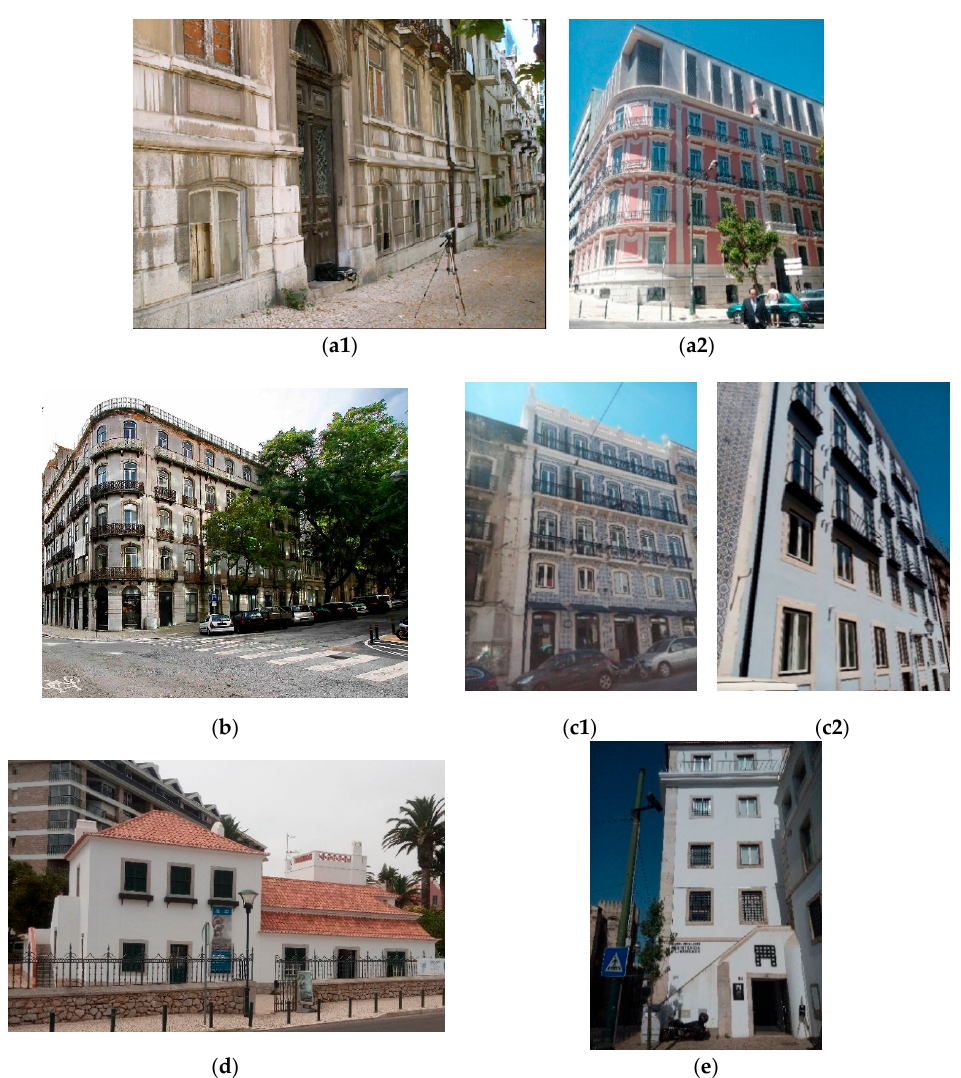
Figure 5. Facades in which thermal insulation was not applied: ( a1 , a2 ) case G before and after retrofit; ( b ) case H before retrofit; ( c1 , c2 ) case J after retrofit; ( d ) case K after retrofit; ( e ) case L after